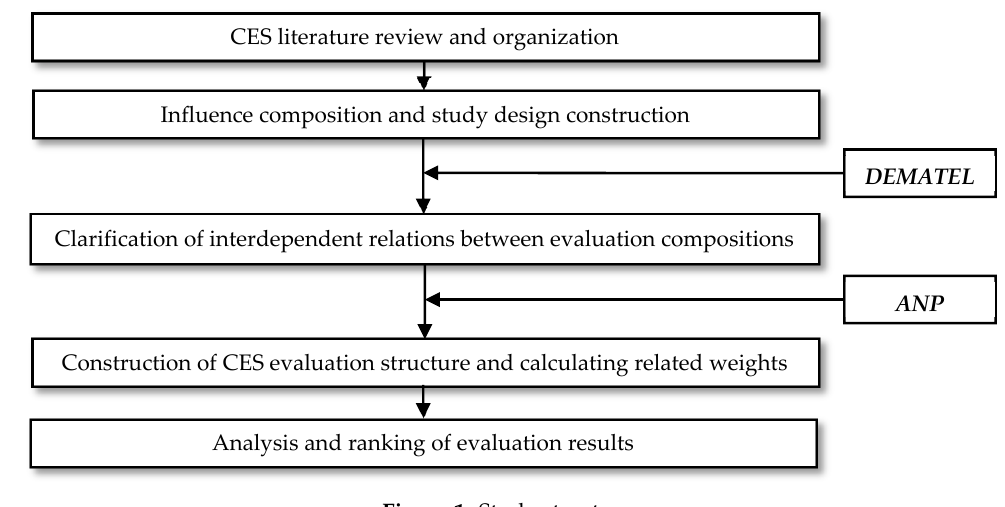
Figure 1. Study Figure 1. Study structure.